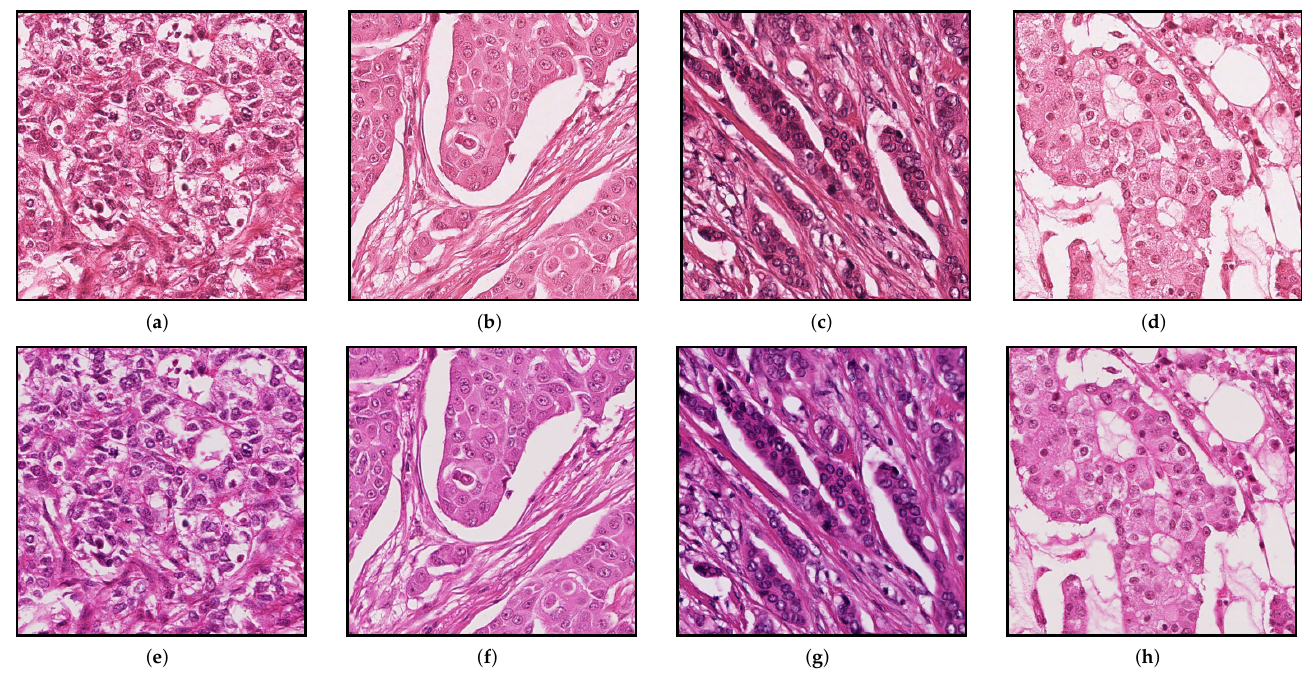
. (a, b, c, d) from Aperio Scanner and (e, f, g, h) from Hamamatsu Scanner. Figure 1. Patches at resolution 20 × . ( a – d ) From Aperio Scanner and ( e – h ) from Hamamatsu Scanner. Figure 1. Patches at resolution 20 × Summary of